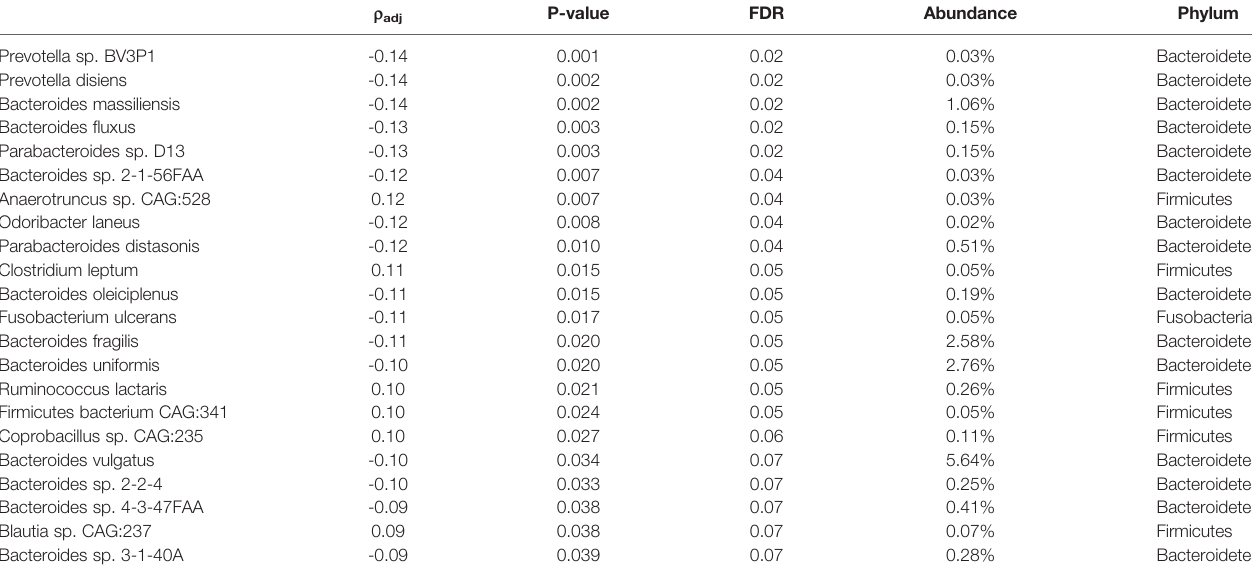
Correlationcoef fi cientsandp-valuescorrespondtotheeffectsofthemicrobesindividuallytestedinpartialSpearmancorrelationanalyses.Associationsareadjustedforage,BMI,exercise, yearssincemenopause,FSH,andestradiol.FDRcorrectionaccountsfortestingthesubsetofbacteriaspeciesselectedintheinitialfeaturescreeningbyconstrainedelasticnetregression. Abundance refers to the average relative abundance across all